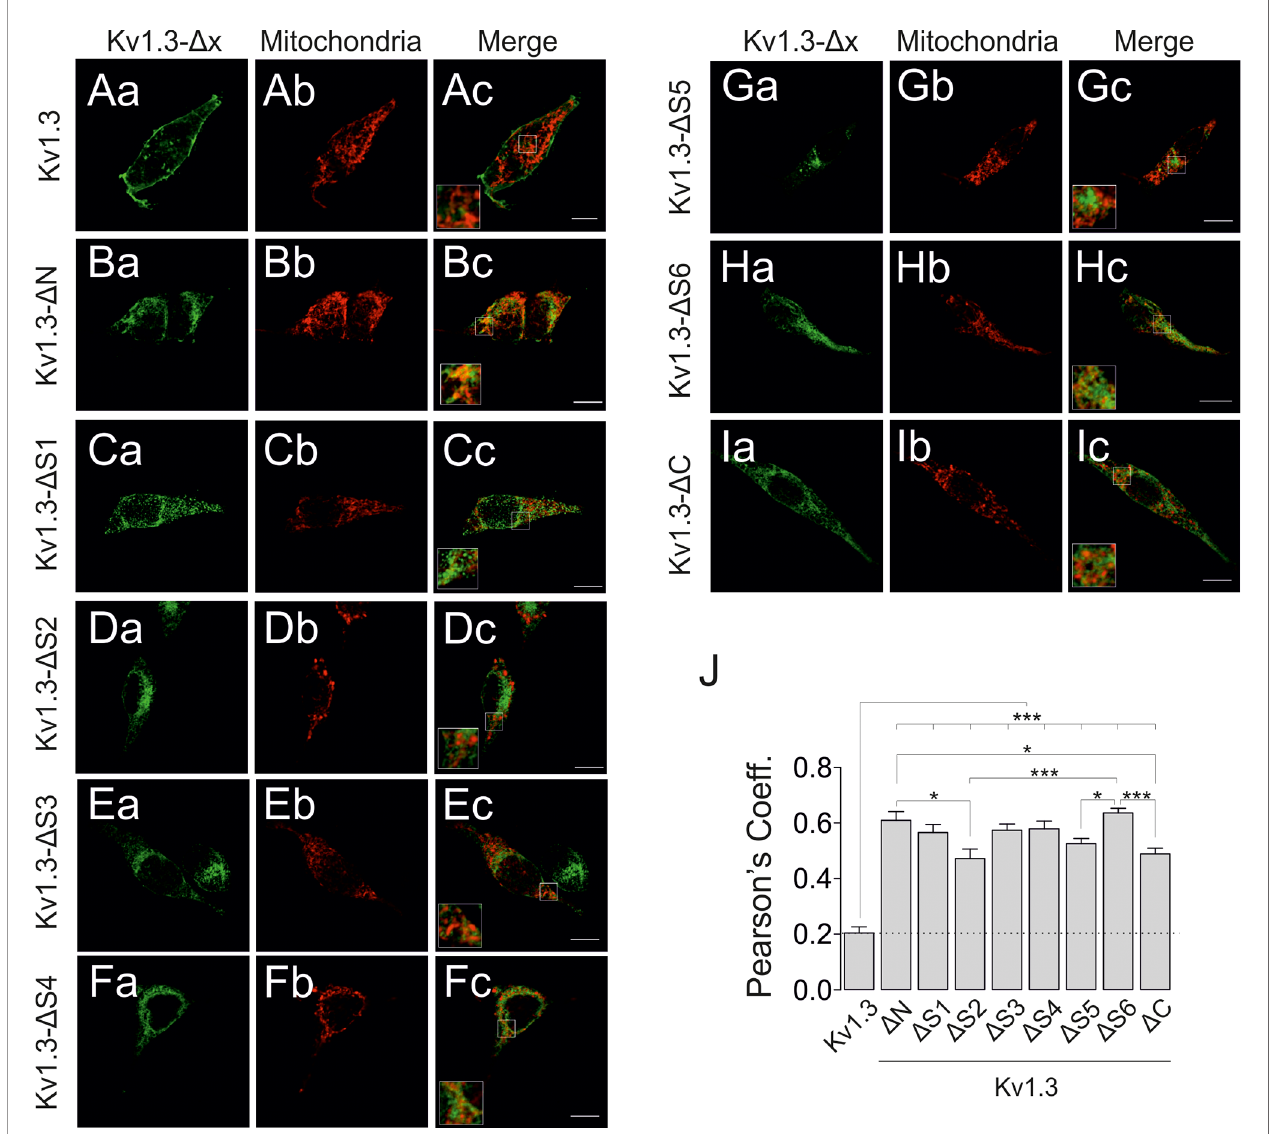
FIGURE 5 | Mitochondrial targeting of Kv1.3 depends on structural information rather than on discrete motifs. HEK 293 cells were transfected with several Kv1.3- D x channels, and mitochondrial colocalization was analyzed. (A – I) Representative confocal images of different Kv1.3YFP constructs (a, green) and the mitochondrial marker (b, pmitoRFP in red). Kv1.3- D x indicates the transmembrane segment deleted from the expressed Kv1.3YFP construct. Kv1.3- D N (B) and Kv1.3- D C (I) indicate deletion of the N- and C-termini, respectively. Panel c (merge) shows colocalization in yellow. Square inset indicates the region shown at higher magni fi cation. The scale bar represents 10 µm. (J) Quanti fi cation of mitochondrial colocalization using Pearson ’ s correlation coef fi cient. The dashed line highlights the Kv1.3 WT value. Data are presented as the means ± SE (n>30). *p < 0.05 and ***p < 0.001 (one-way ANOVA and Tukey ’ s post hoc